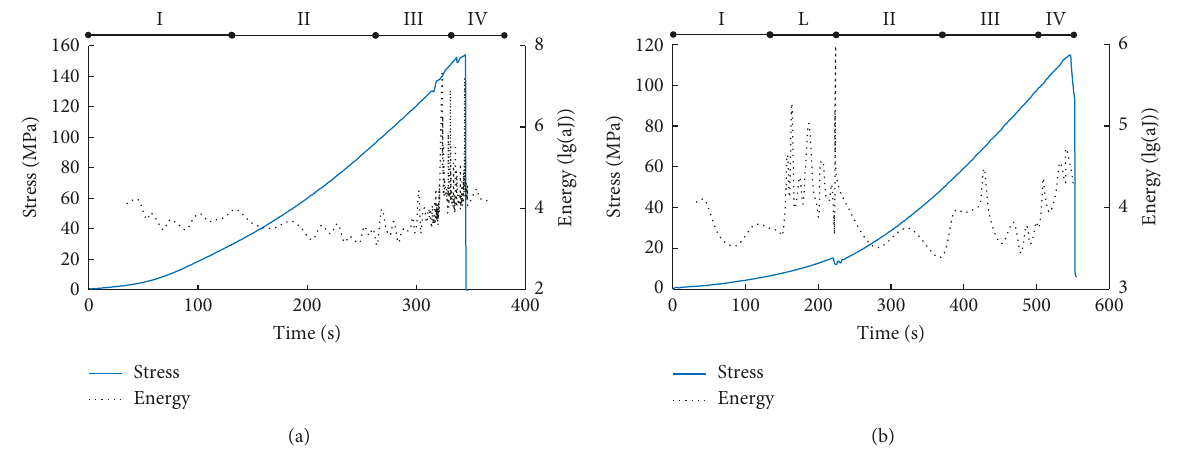
Figure 4: Changes of energy with time: (a) Sim2; (b)